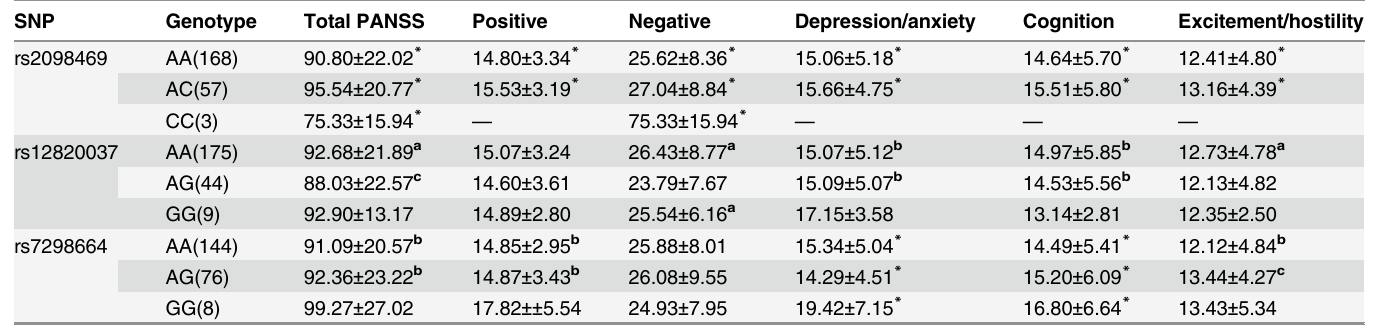
Table 3. Association analyses between five factors of PANSS and three GRIN2B SNPs in patients with SZ.